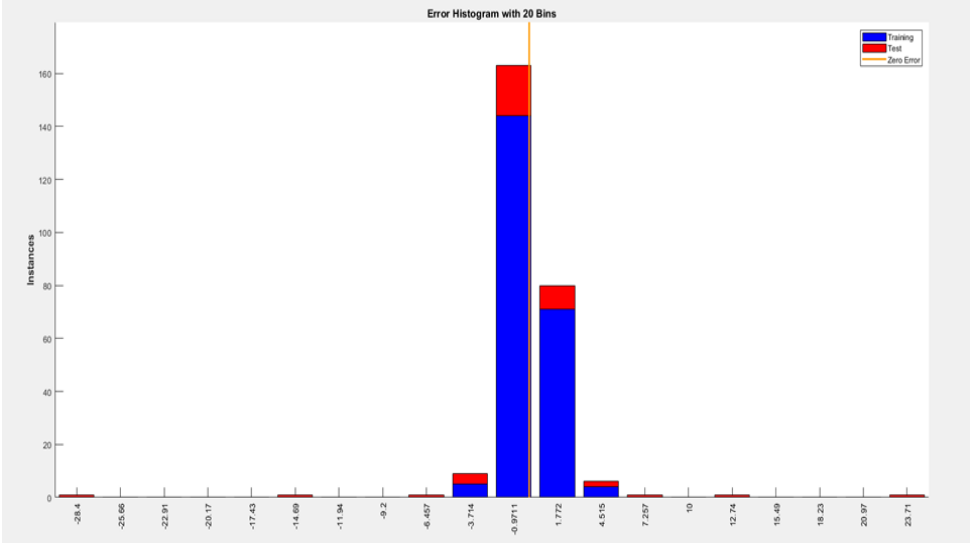
Figure 11. Error histograms of proposed hybrid system for neural network controller.